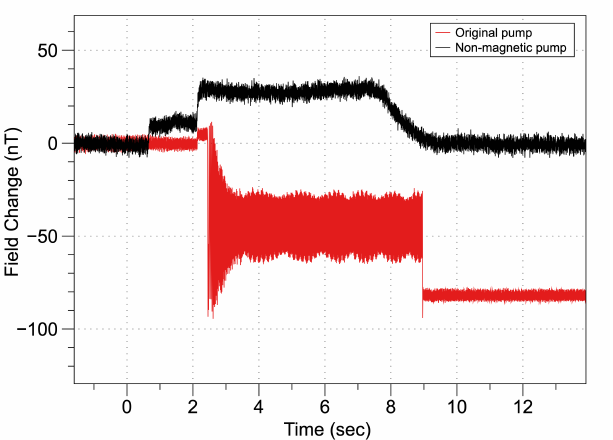
Figure 8. Magnetic fields created during the operation of ROUGHIE’s ballast pump. Note that the original pump had a magnetization that would land in an arbitrary position, resulting in an unpredictable offset to the field. The new non-magnetic pump however, returns to the same field strength upon being